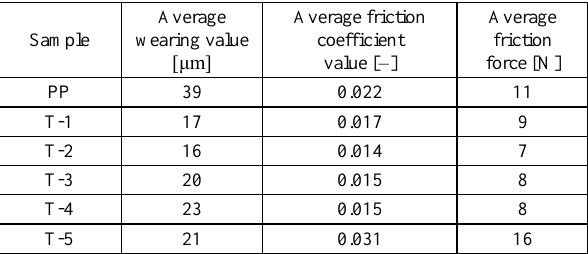
Table 4. Average values obtained after tribotester test